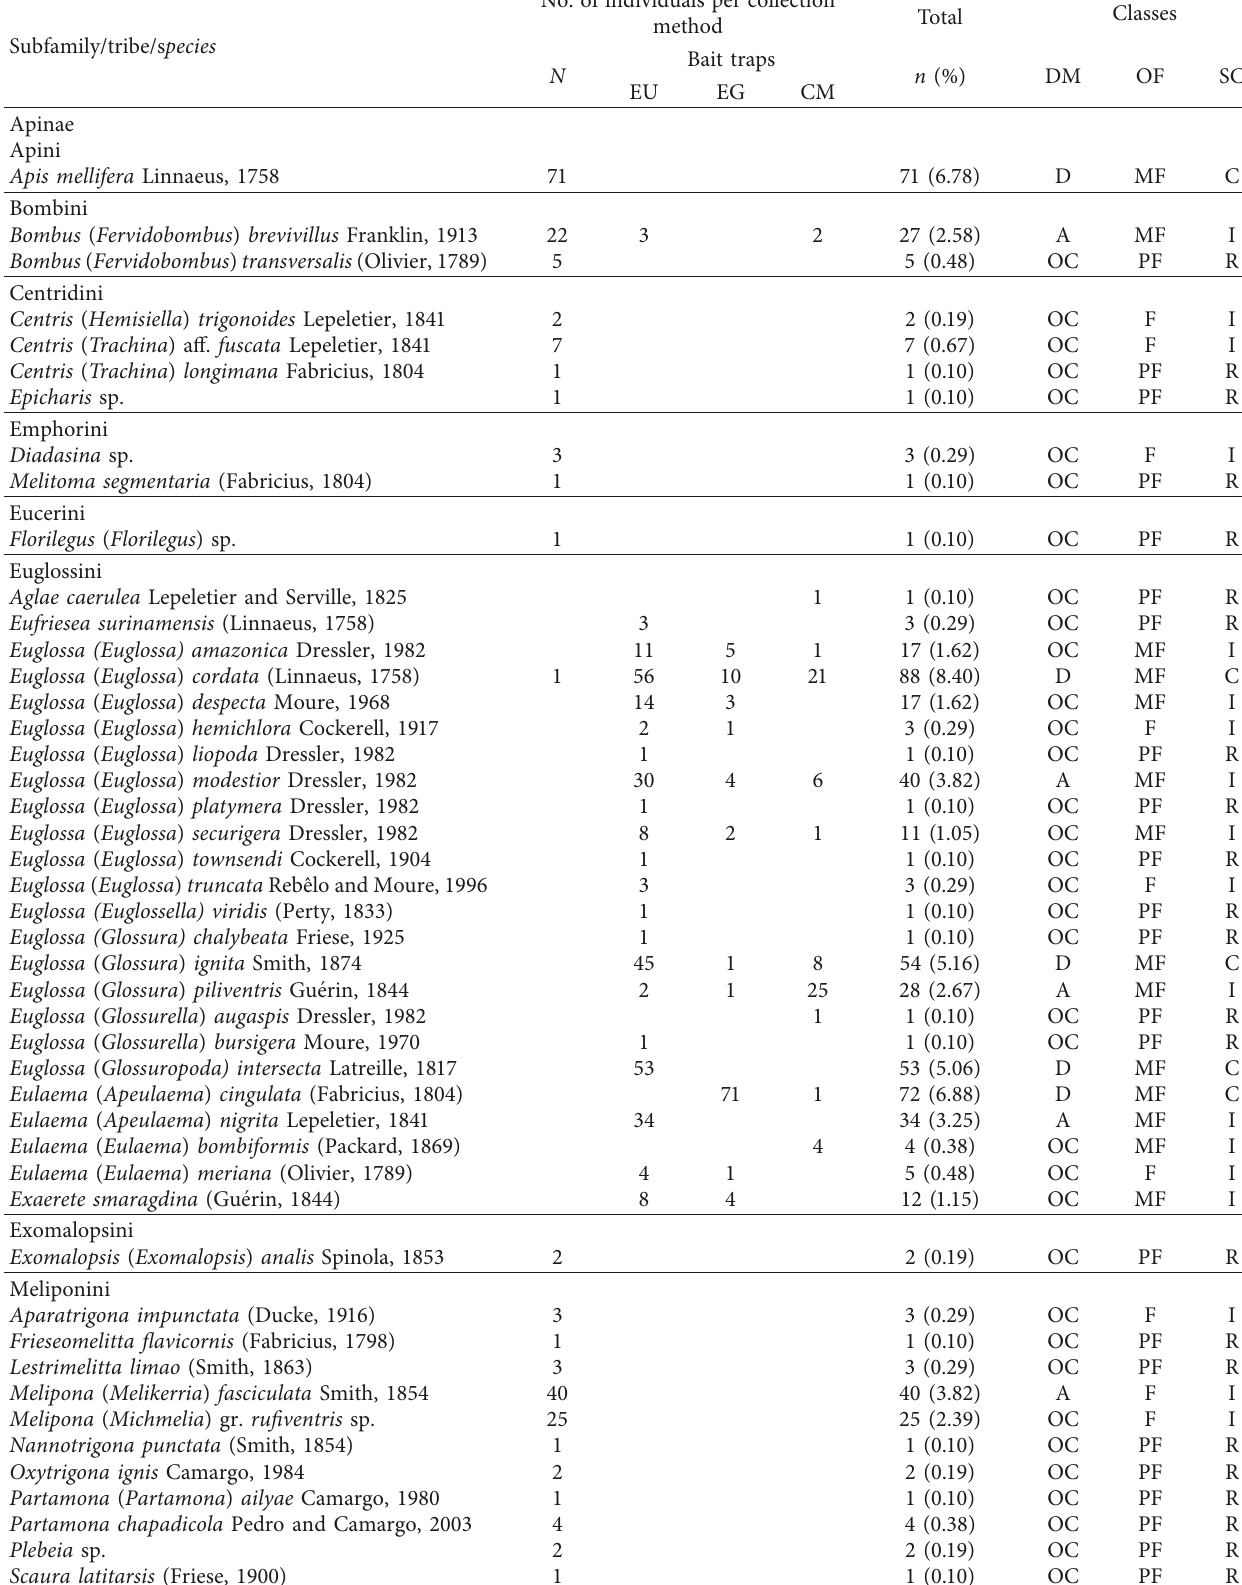
Table 1: Bee species recorded in Carutapera